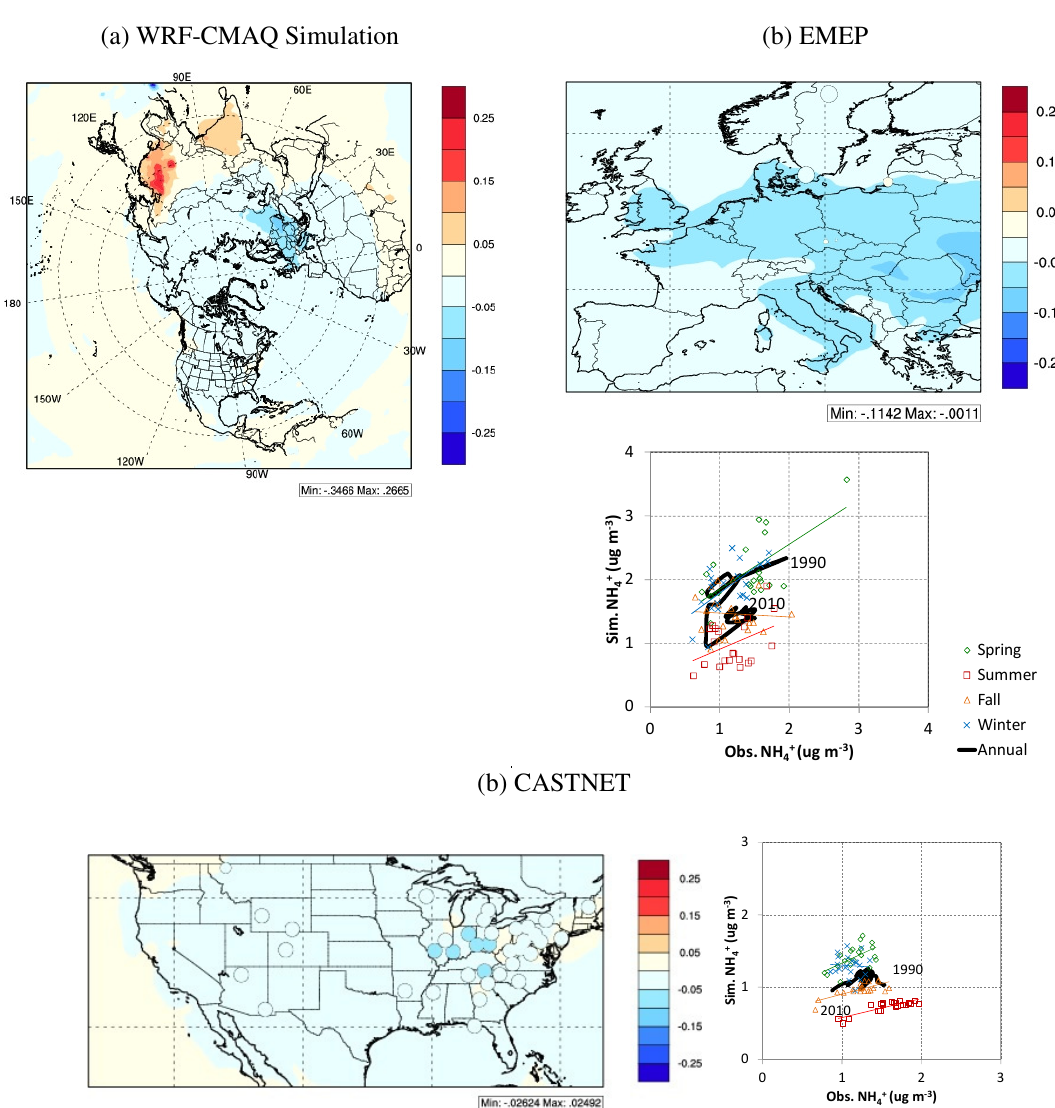
Figure 8. Same as Fig. 3 for NH +